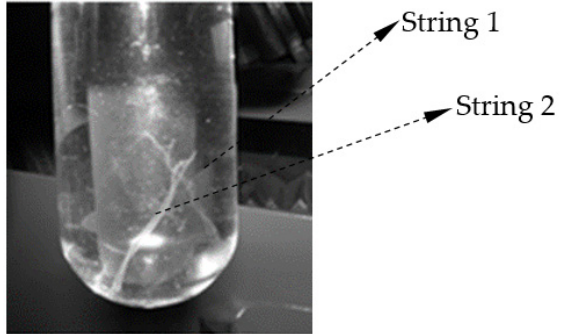
Figure 7. Photograph of UV-crosslinked polymer showing the generation of two strings in cyclohehane after a period of 48 h from the initial time of immersion.